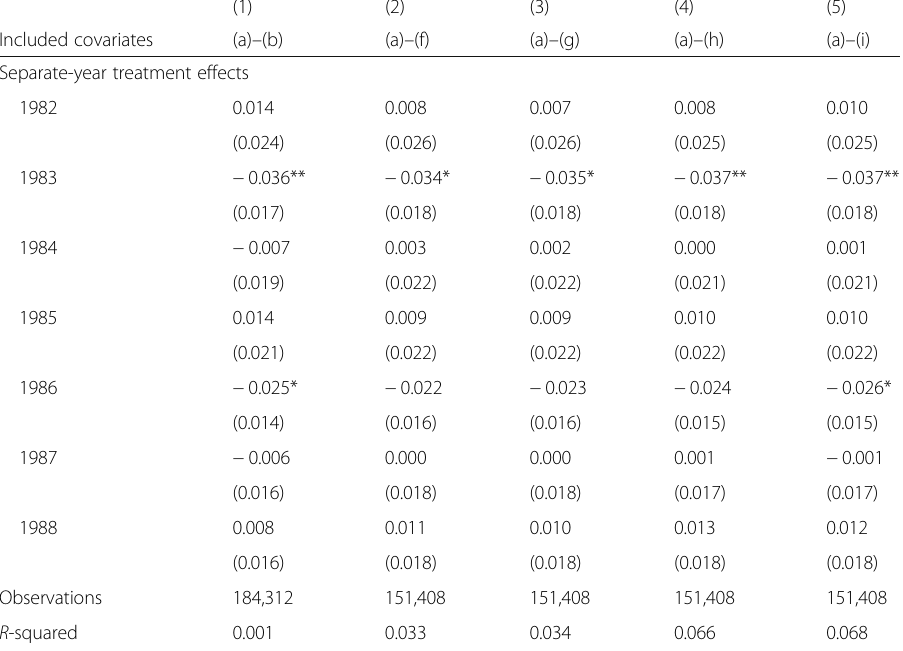
Table 7 Estimated impacts of Mariel Boatlift (using all other unaffected MSAs as the